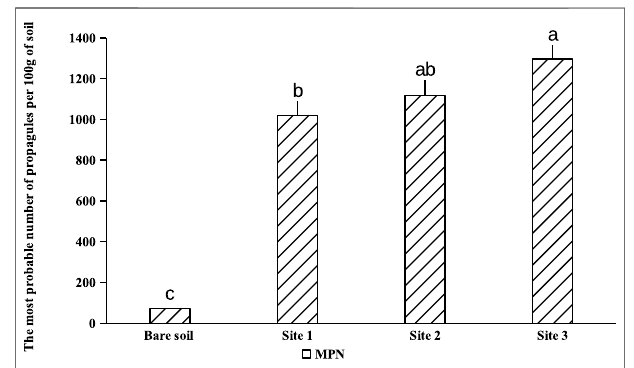
FIGURE 4 | The most probable number of fungal propagules in different rhizospheric soils of Acacia cyanophylla in the sand dune ecosystem of Essaouira.Bar-graphsindexed bythesameletterarenotsigni fi cantlydifferent according to the Tukey test (HSD) ( p < 0.05 ).